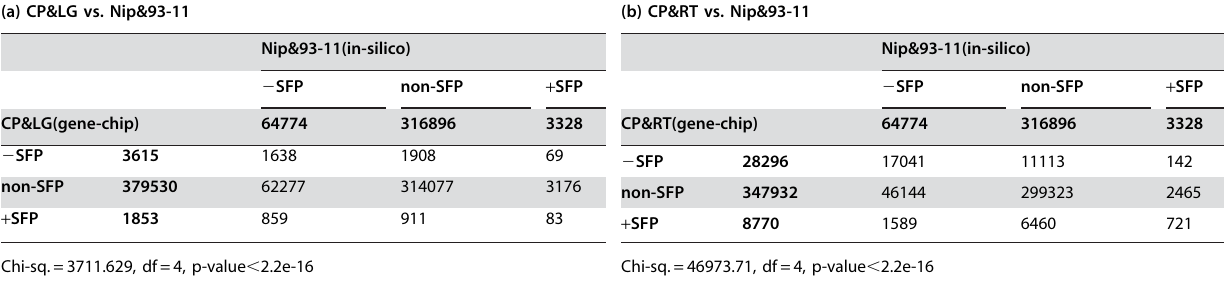
Table 6. Overlapping SFPs between datasets of gene-chip experiments and in-silico analyses. .. ... .... ... ... .... ... ... .... ... ... .... ... ... .... ... ... .... ... ... .... ... ... .... ... ... .... ... ... .... ... ... .... ... ... .... ... ... .... ... ... .... ... ... .